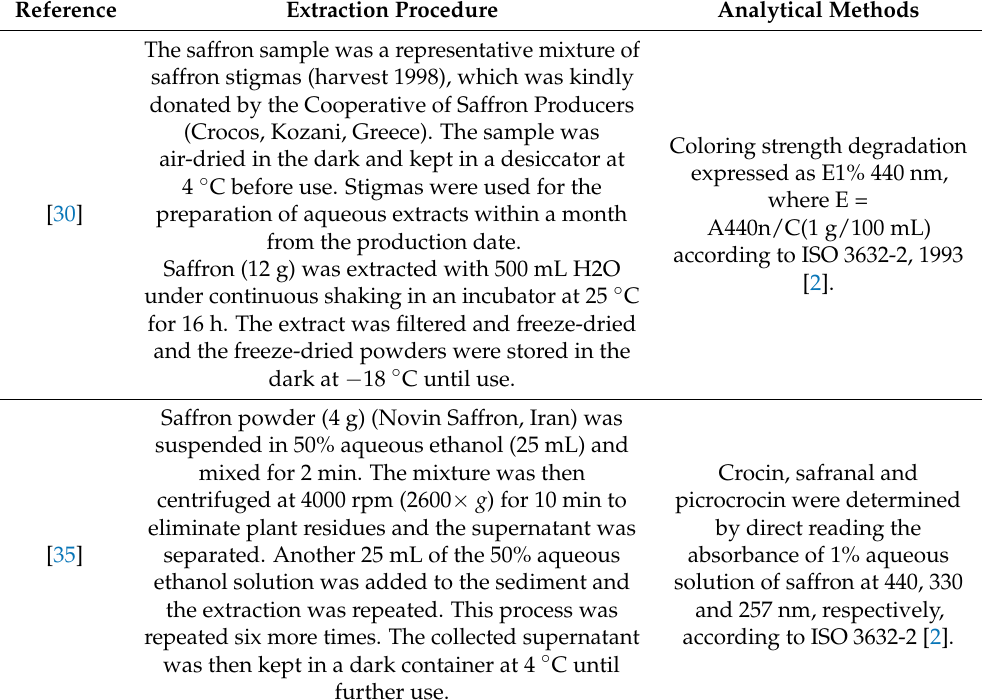
Table 3. En(nano)capsulation approaches for saffron bioactive antioxidants with focus on the char- acteristics of saffron as the starting material, extraction and analytical methods for their isolation and